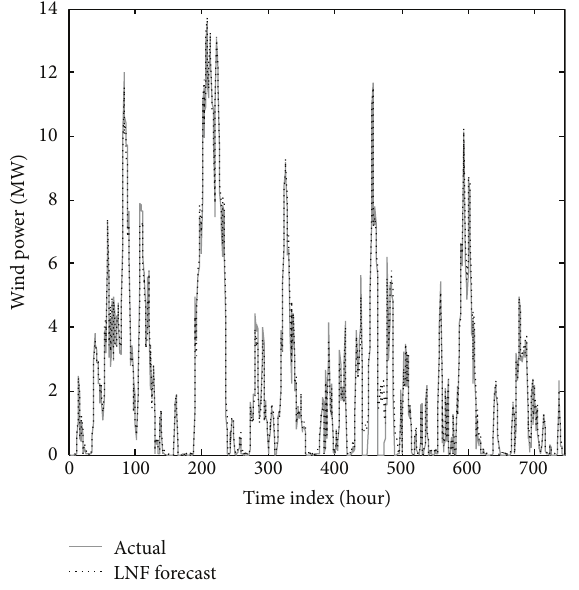
Figure 8: Actual and forecasted wind power for May 2010.